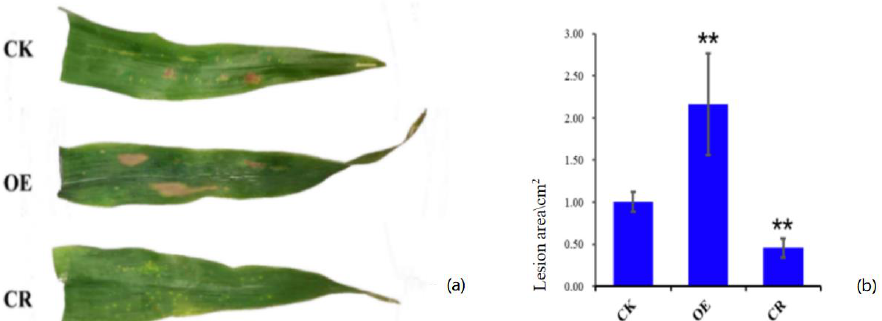
Figure 2. Incidence of large spots in transgenic plants inoculated: ( a ) incidence of leaf; ( b ) leaf spot area statistics. ** means significant difference compared with the control ( p ≤ 0.01). CK: control plants; OE: transgenic plants overexpressing the ZmBON3 gene; CR: ZmBON3 -gene-edited plants.